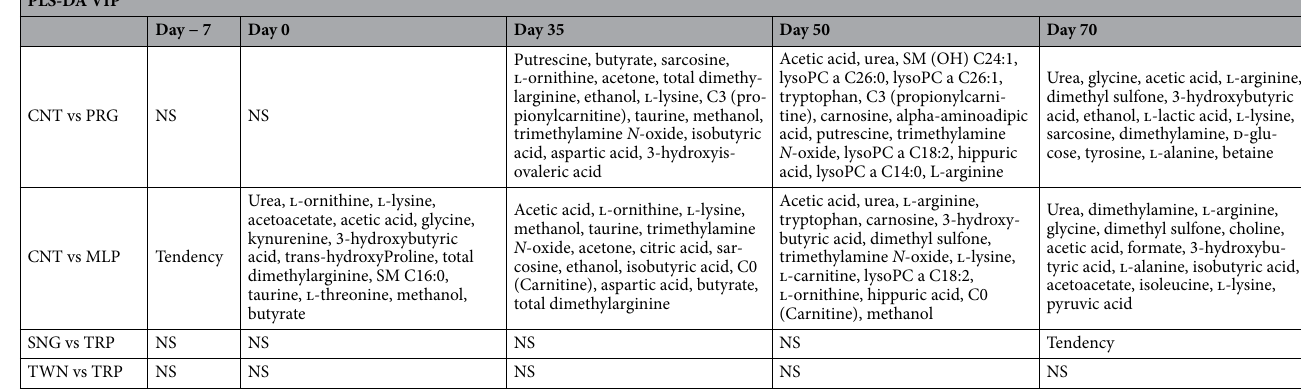
Table 4. Partial least squares discriminant analysis (PLS-DA) analysis of four comparison groups from the discovery dataset. Multivariate statistical analysis of the discovery dataset using PLS-DA revealed top 15 metabolites that significantly (p-value < 0.05) differentiate between the two comparison groups at each timepoint. NS Not significant, CNT control open ewes, PRG pregnant ewes, SNG pregnant ewes that delivered one lamb, TWN pregnant ewes that delivered two lambs, TRP pregnant ewes that delivered more than two lambs. Day − 7 refers to seven days prior to initiation of gestation and day 0 is the start of